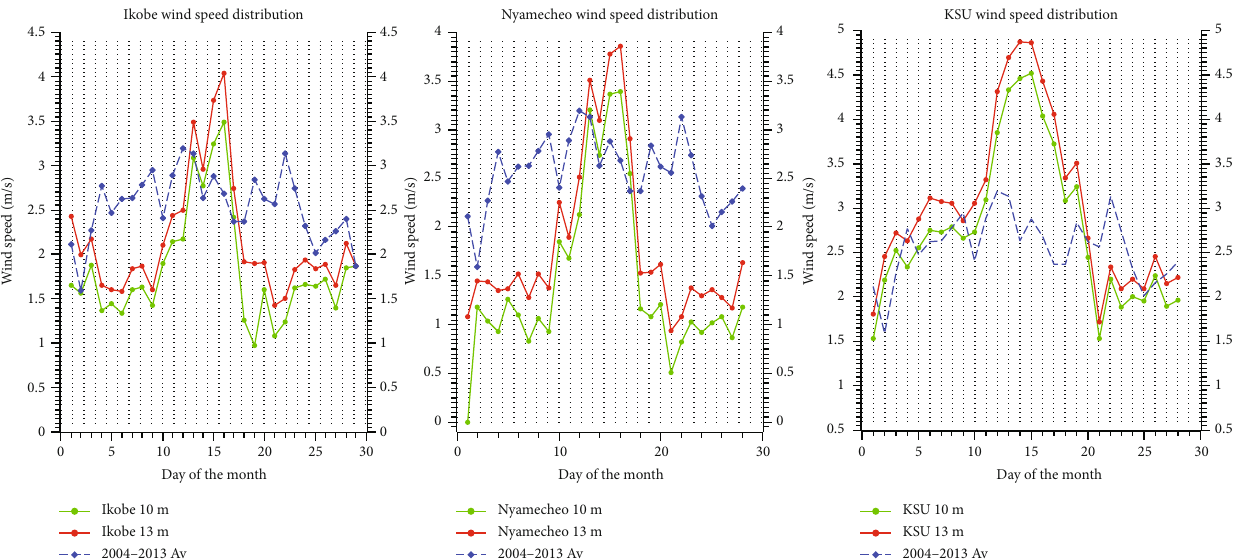
Figure 4: February ’ s wind speed distribution pattern in comparison to 10 years of